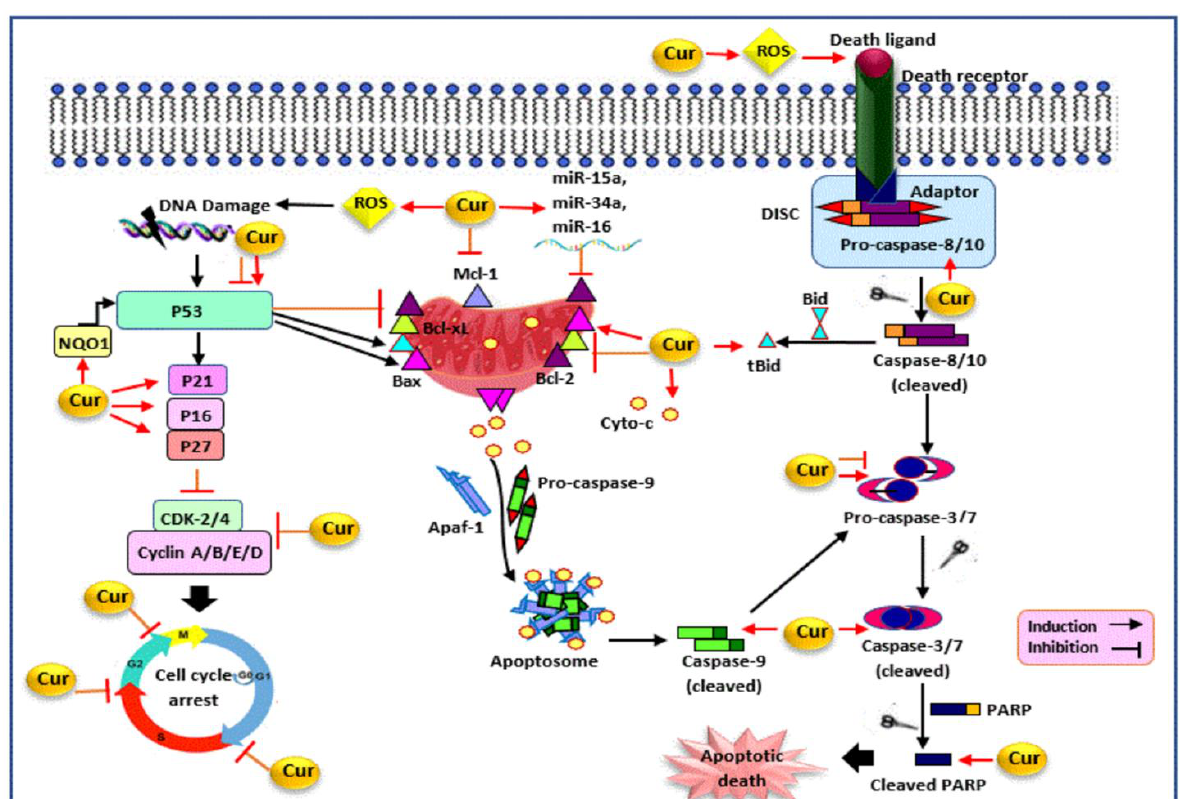
Figure 5. The modulatory effect of curcumin on p53, cell cycle, and apoptosis pathways. Curcumin inhibits cell cycle progression and induces apoptosis by targeting various molecules. Curcumin triggers ROS generation and alters the expression level of caspases (caspase-3/7, 8, 9), PARP, Bcl-2 family proteins (Mcl-1, Bcl-xL, Bid, Bax, Bcl-2), cytochrome-c, and miRNAs (miR-34a, miR-15a, miR-16), which results in apoptotic cell death in hormone receptor negative breast cancer.